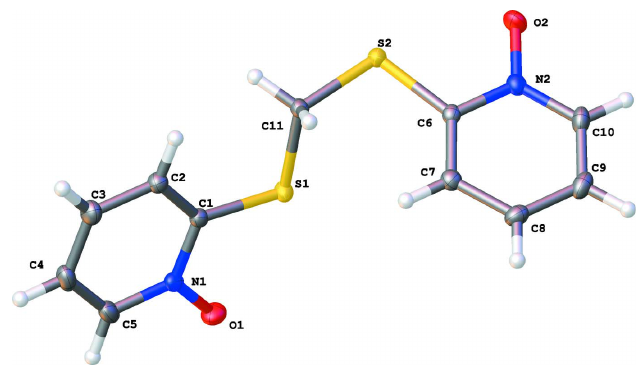
Figure 1 The molecular structure of the title compound shown with 50% probability ellipsoids.